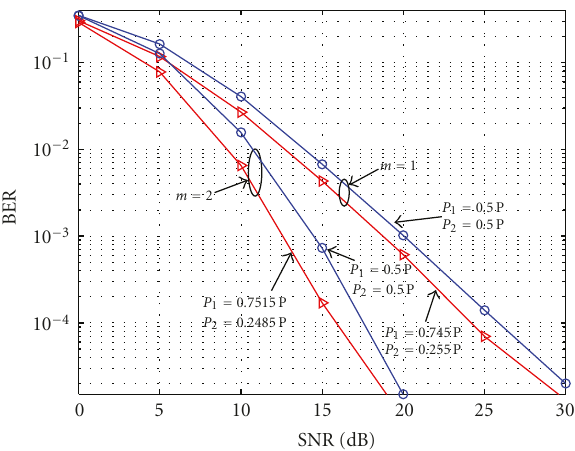
Figure 5: Analytical and experimental BERs versus SNR perfor- mance of DDAAF cooperative system over Nakagami- m channels with ◦ m = 1, (cid:12) m = 1 . 5, (cid:2) m = 2, and Δ m = 3.